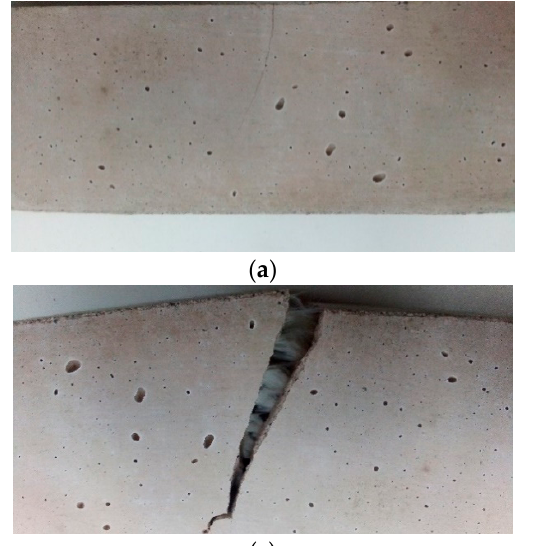
Figure 13. Crack propagation in a geopolymer composite based on metakaolin reinforced with 2.0% glass fiber roving: ( a ) first crack; ( b ) crack after second series of testing; ( c , d ) final damage of the sample.